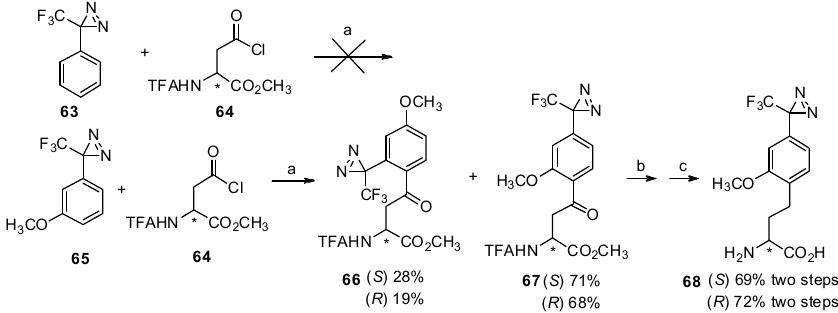
Scheme 12. Synthesis of trifluoromethyldiazirinyl homophenylalanine by Friedel-Crafts